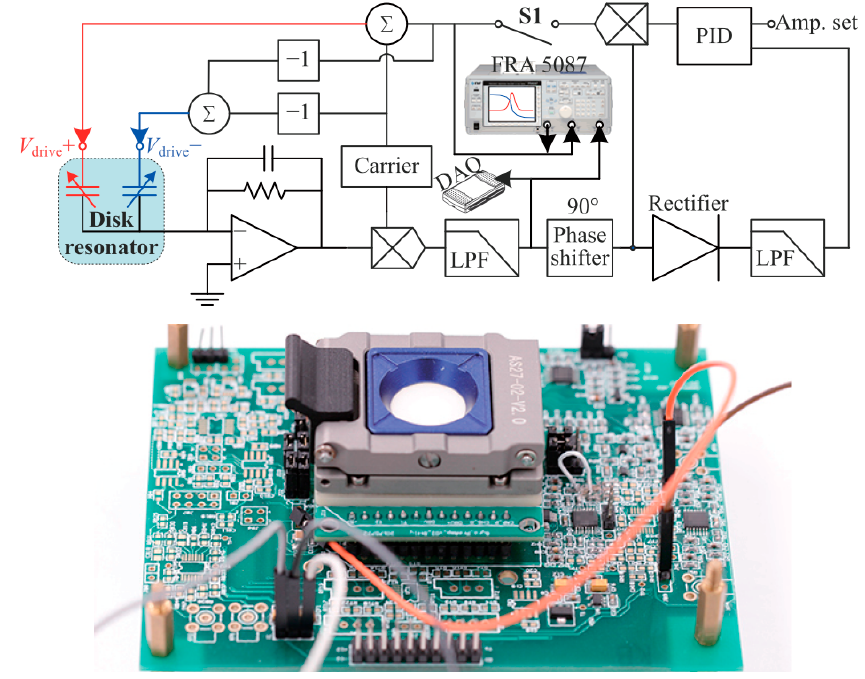
Figure 4. Schematic diagram of the circuit for spectrum and ring-down experiments ( up ) and the testing circuit board ( down ).